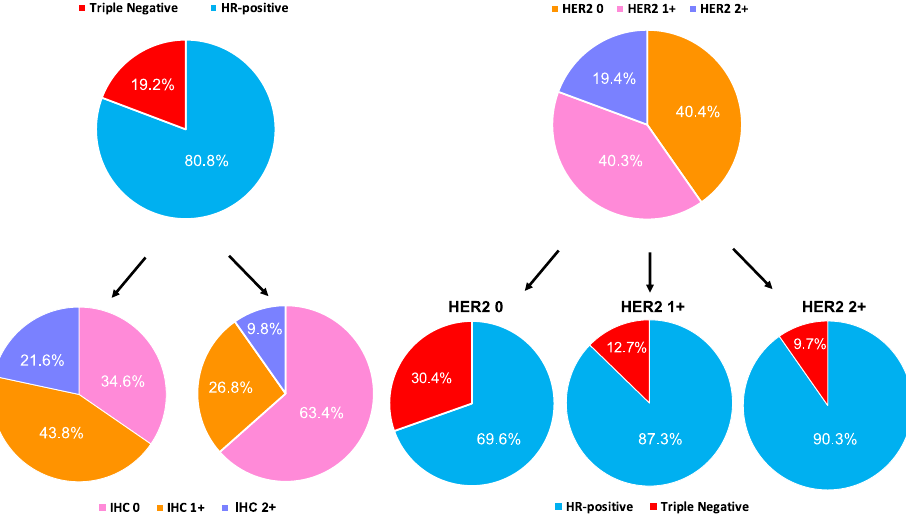
Fig. 2 Hormone receptor status, HER2-low status, and IHC scores distributions within the HER2-negative population. HR hormone receptors, IHC immunohistochemistry, ISH in situ hybridization (including either FISH, SISH, and